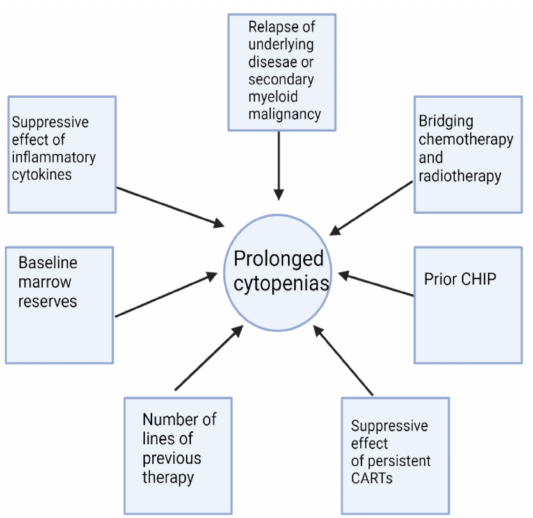
Figure 1. Some possible factors contributing to cytopenias in CAR-T therapy. Several of these variables may be active concurrently. While bridging chemotherapy and radiotherapy contribute to early cytopenias, their occurrence may also influence late cytopenias. Figure generated in Biorender.